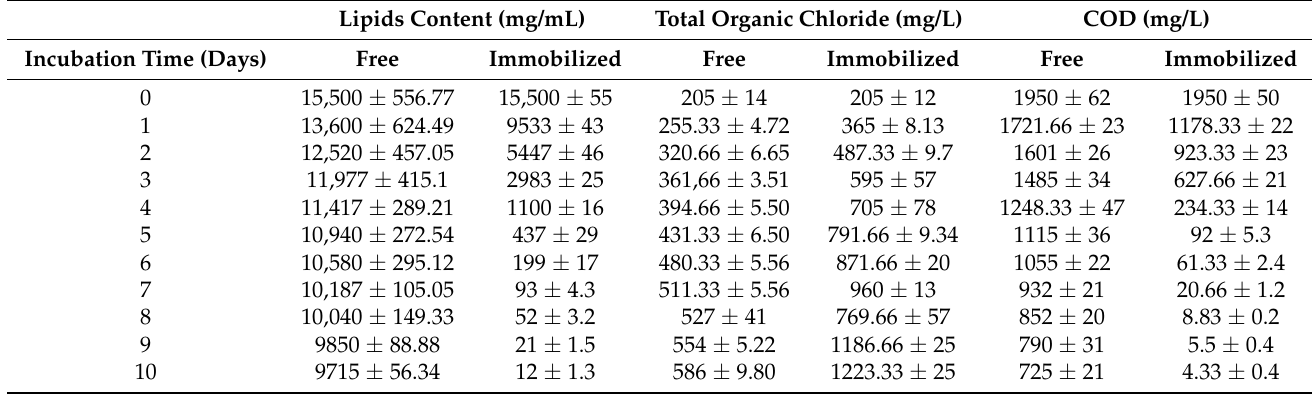
Table 3. Treatment of Wadi Hanifah water by free and immobilized B. stearothermophilus lipase. Lipids Content (mg/mL) Total Organic Chloride